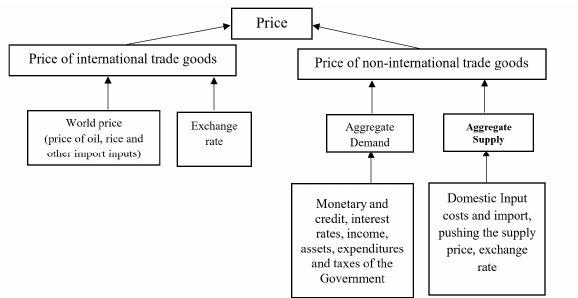
Fig. 1. Transmission channels impact on inflation (Nguyen & Nguyen,